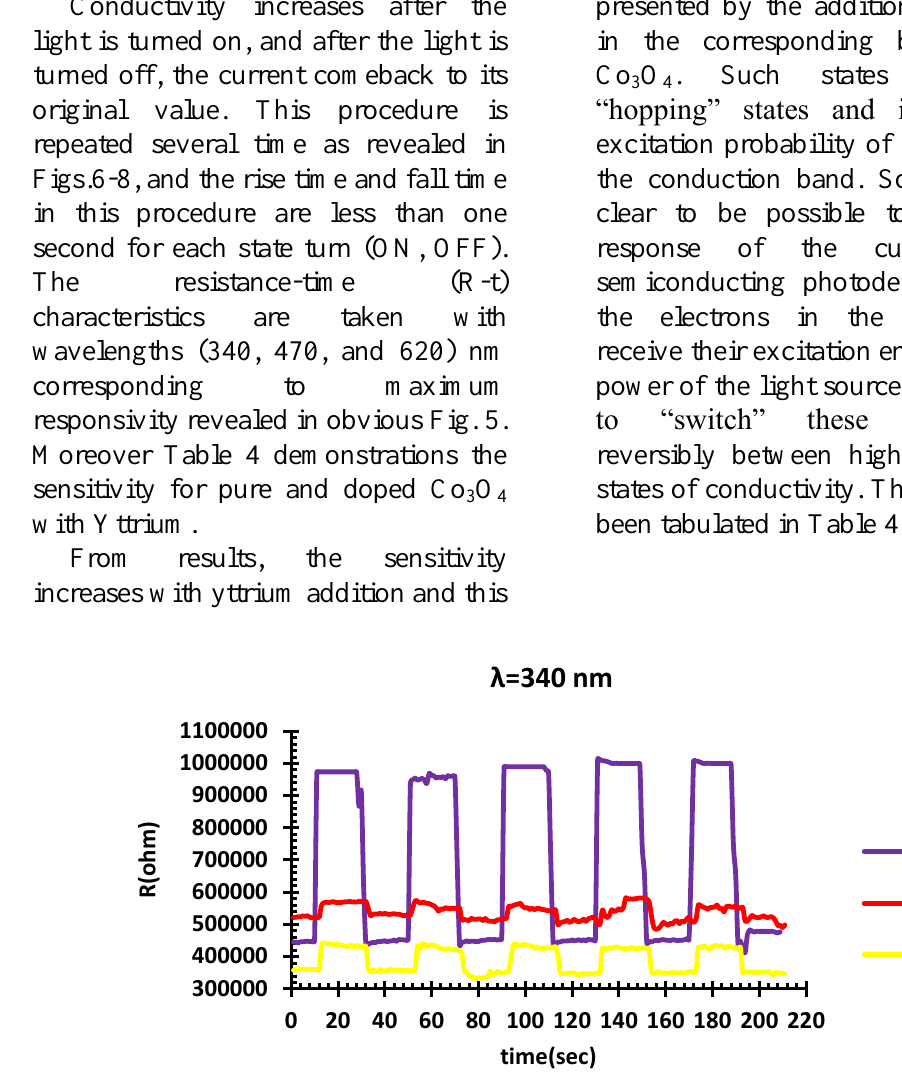
O with yttrium. 3 4